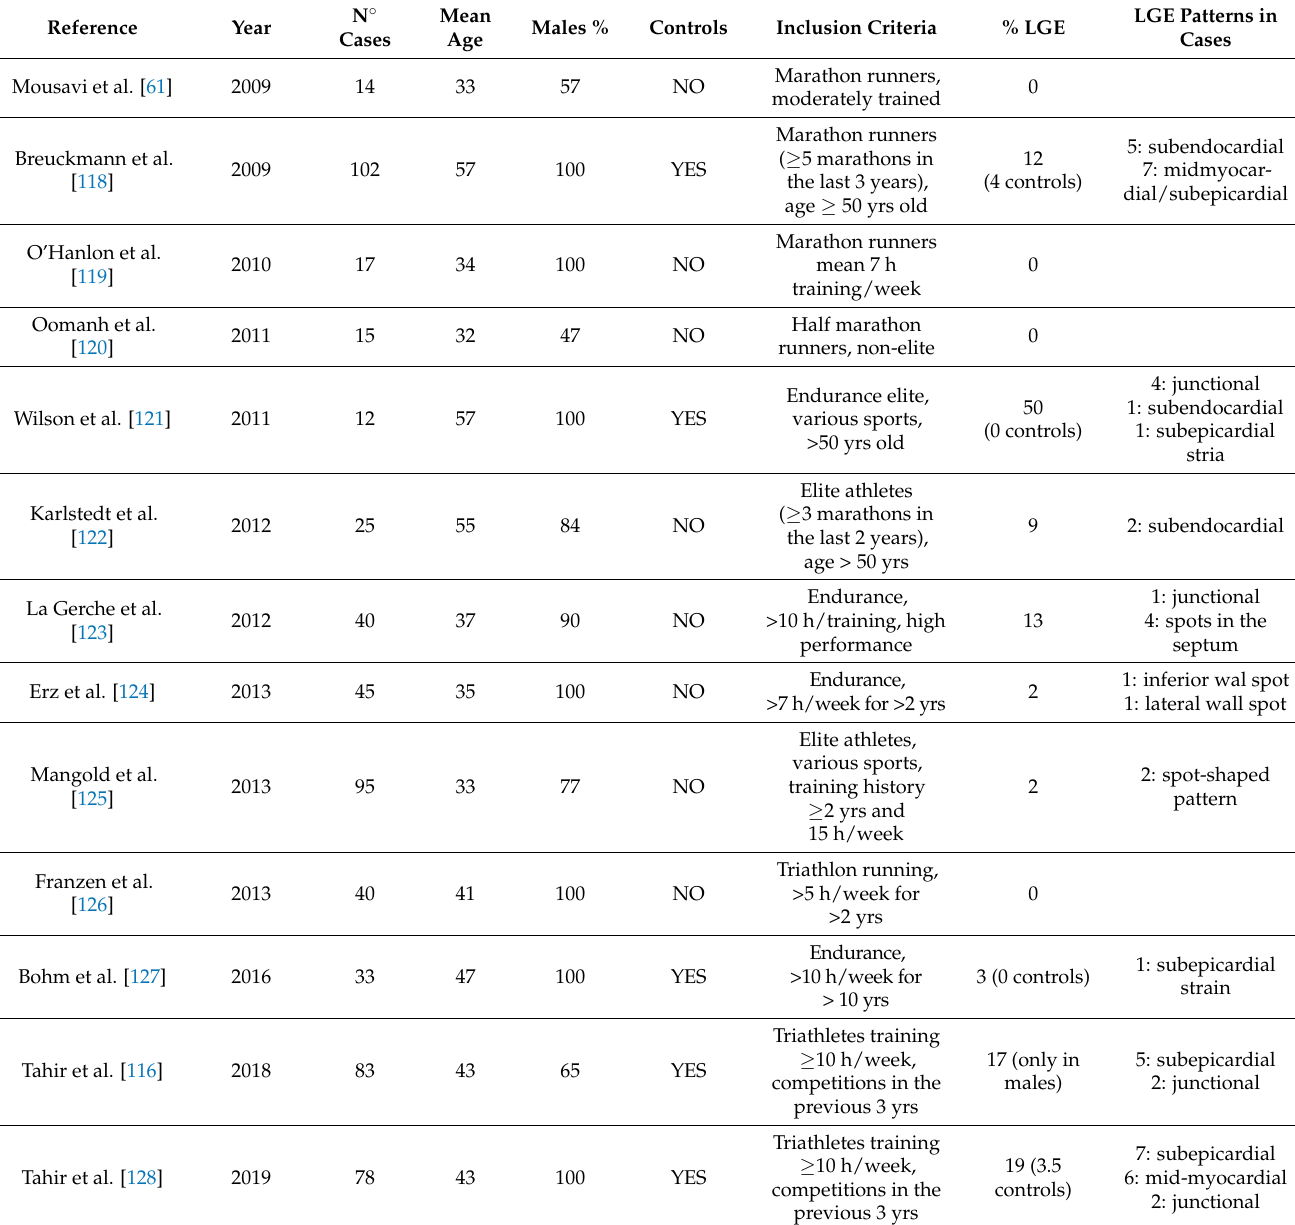
Table 1. Summary of studies investigating the prevalence and characteristics of late gadolinium enhancement in athletes. Yrs = years; LGE = late gadolinium